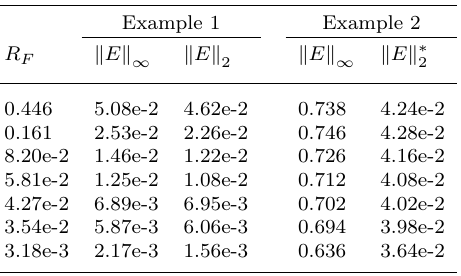
Table 5. Monotonicity analysis of local minima using the Fourier symbol R F Example 1 Example